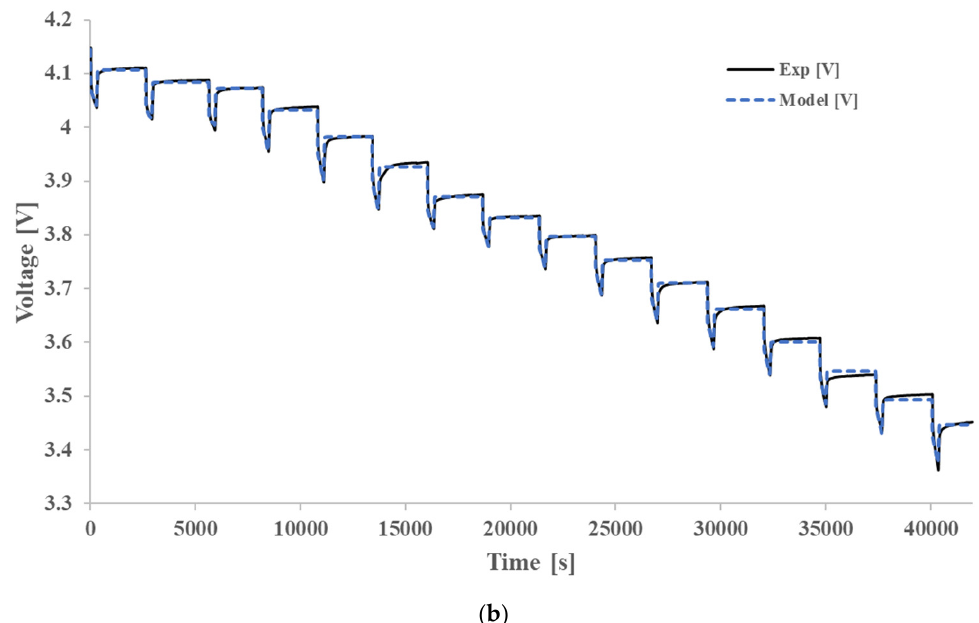
Figure 7. Parametrization results for the second-order ECM compared to experimental results, ( a ) applied current profile in HPPC test versus time and ( b ) cell voltage response in different times calculated by model and obtained in HPPC tests.